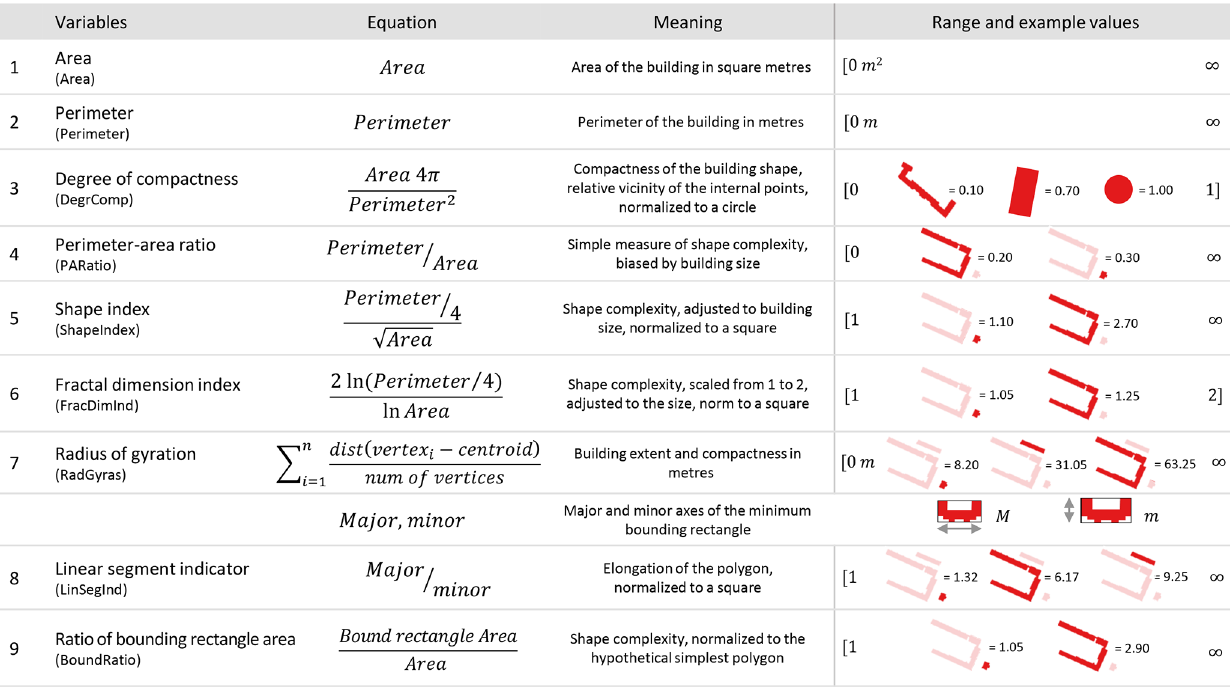
Table A1. Definition and examples for numerical spatial